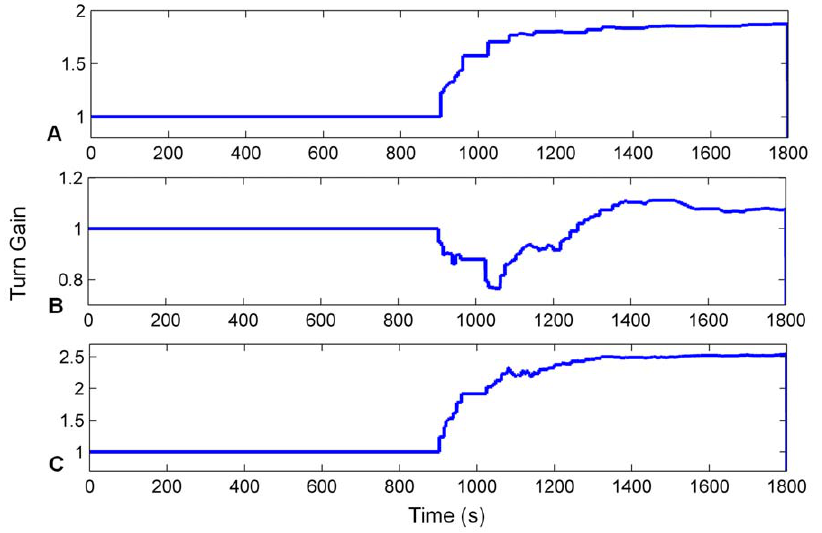
Figure 11. Turn gain calibration varied with different modifications to movement strategy. In all cases turn gain should have stabilised around 0.8 (see Figure 8C). (A) Small lateral head turns, but no 360 u turns. (B) 360 u turns, but no small head turns. (C) Sensory input uncorrelated with head